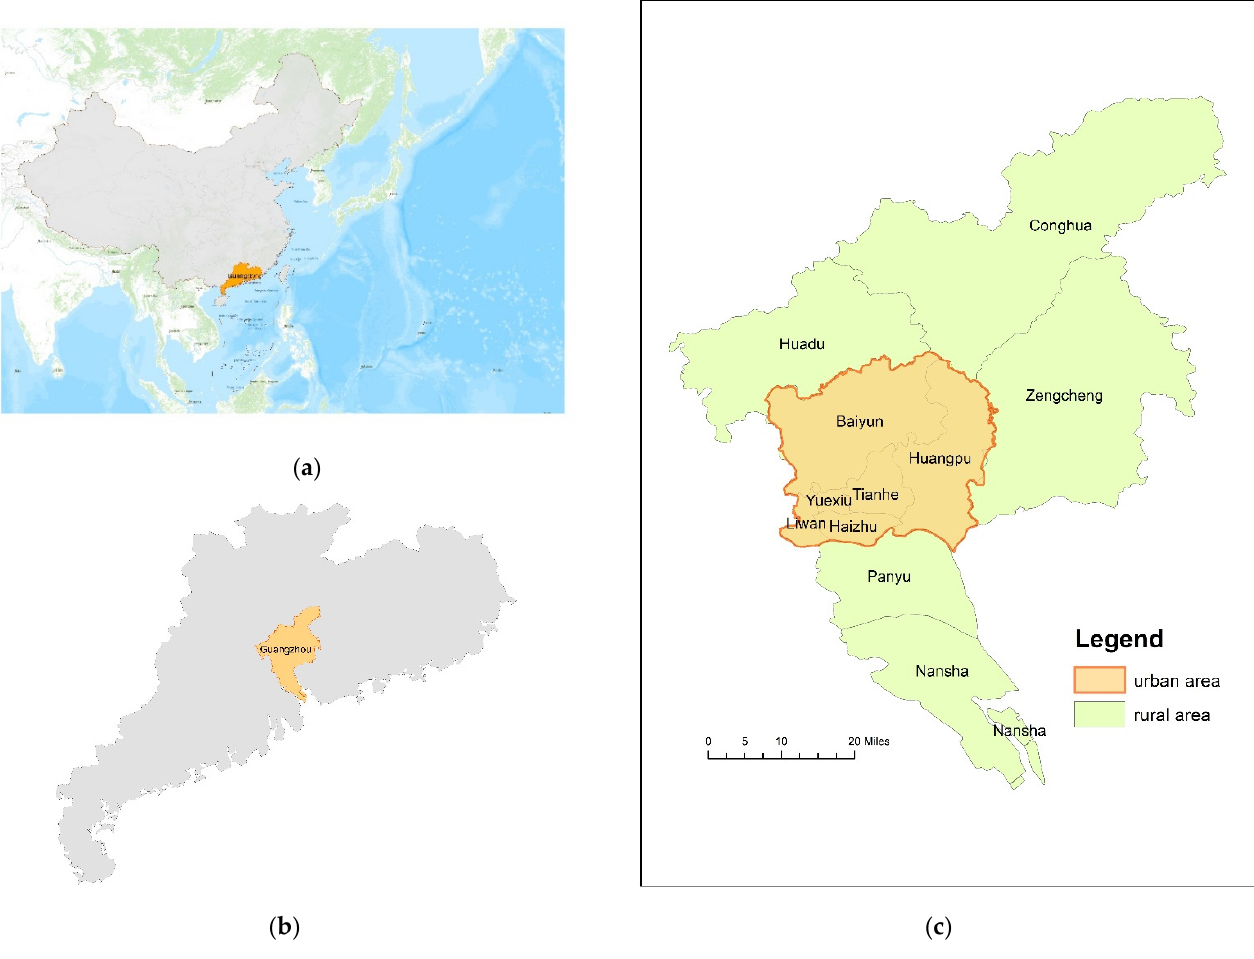
Figure 1. Location of study area, Guangzhou and administrative district division. ( a ) Location of Guangdong province in China; ( b ) location of Guangzhou in Guangdong; ( c ) spatial administrative areas of Guangzhou.